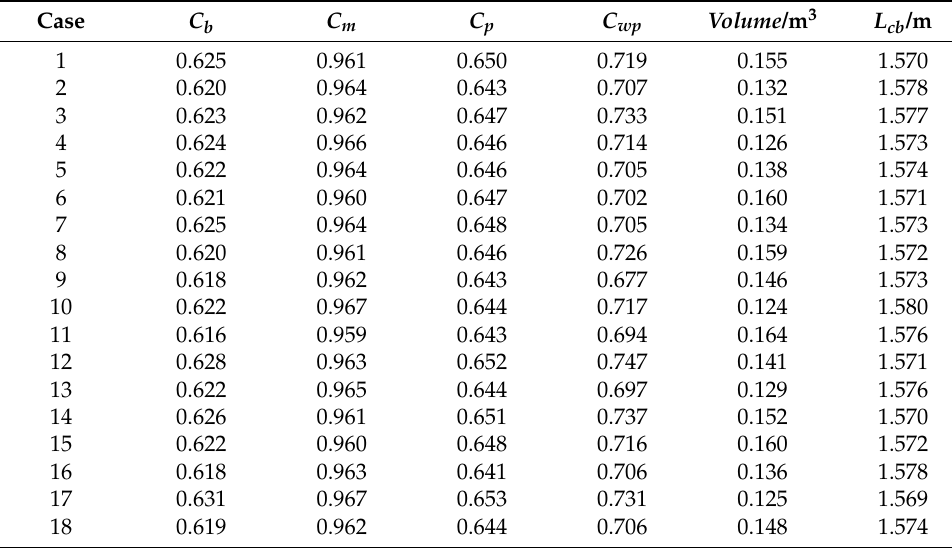
Table 8. The hydrostatic data corresponding to each case.